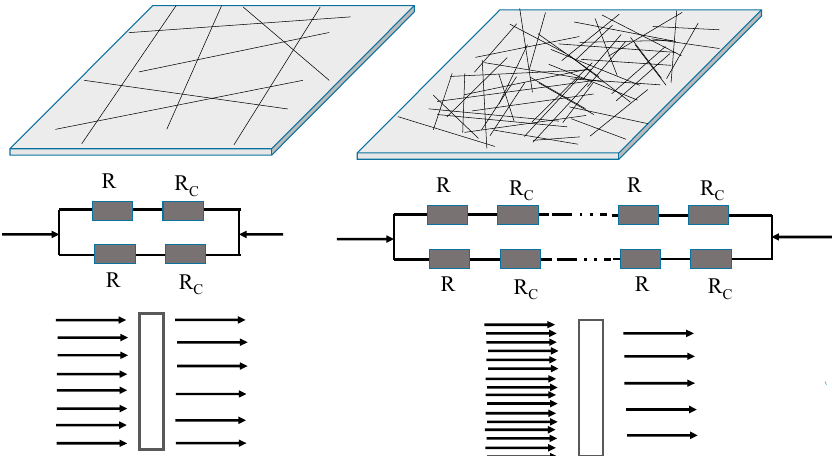
Figure 8. Schematic diagram of the relationship between the AgNWs length and optoelectronic properties of their thin films.